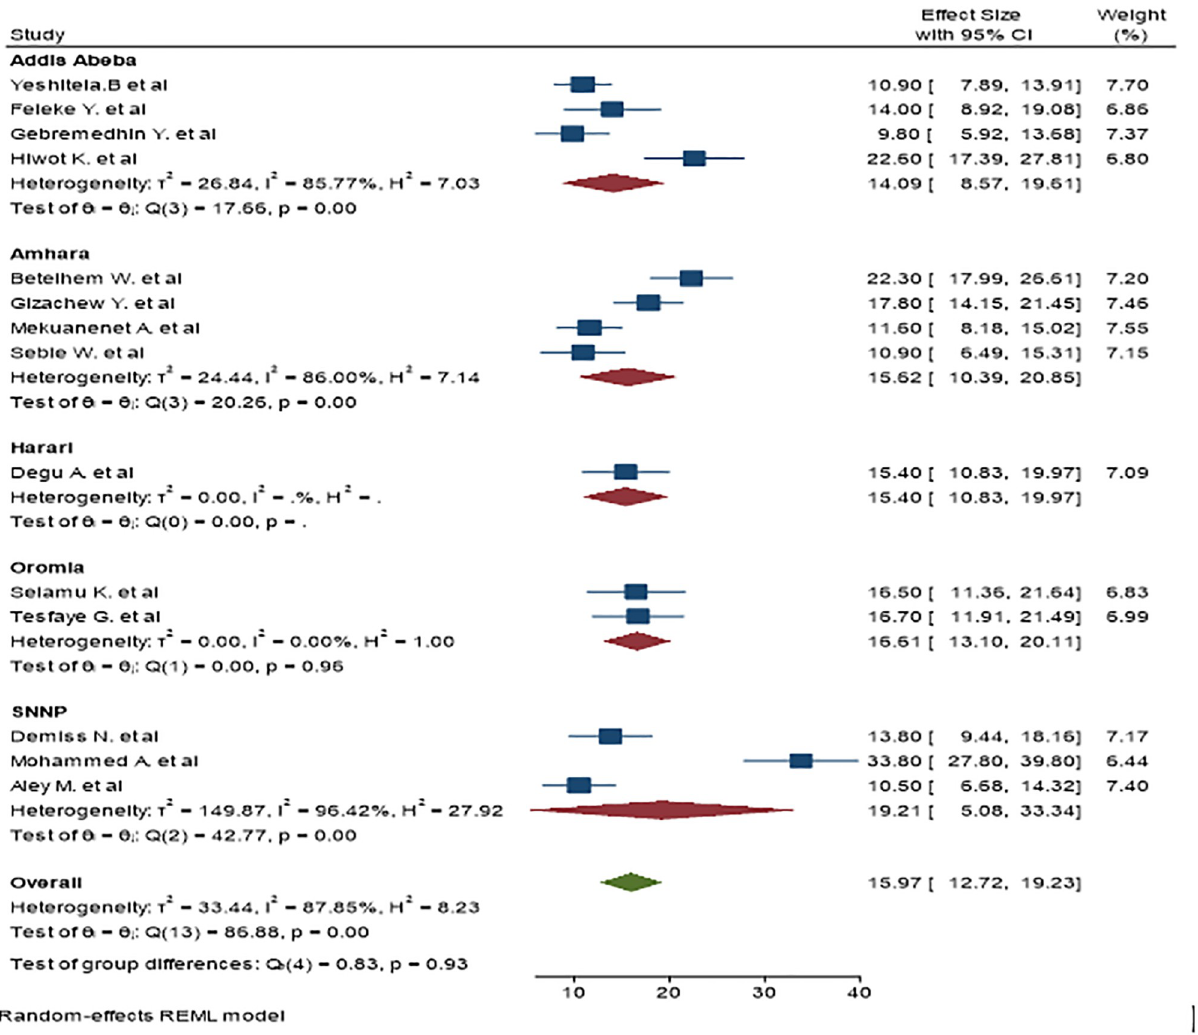
Fig 3. The pooled prevalence of UTI among diabetic patients based on